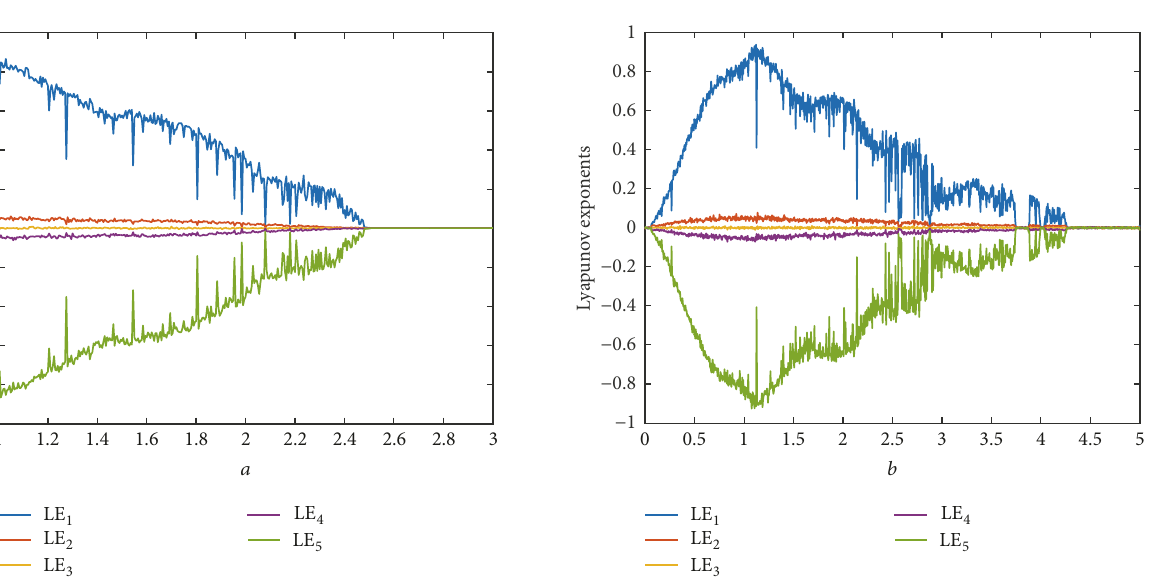
Figure 1: The dependence of finite-time local LEs of the system (2) on parameter 𝑎 , with 𝑏 = 1 .